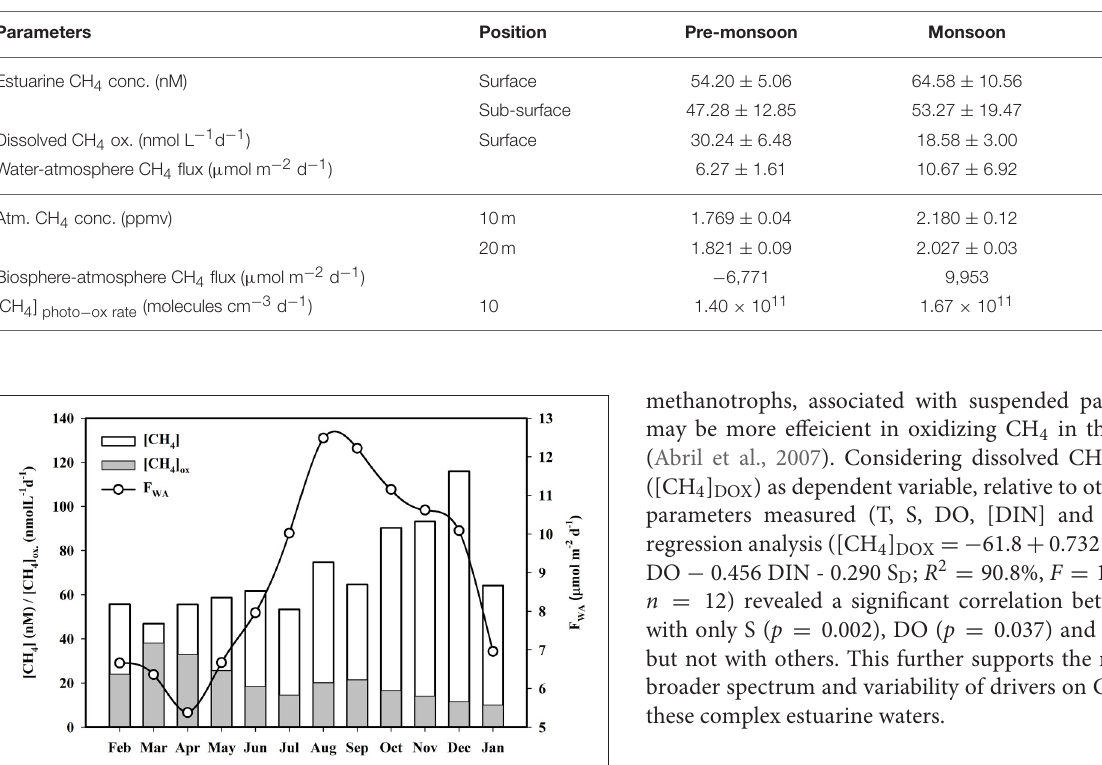
n = 8; post-monsoon: R 2 = 75.8%, F = 18.83, p